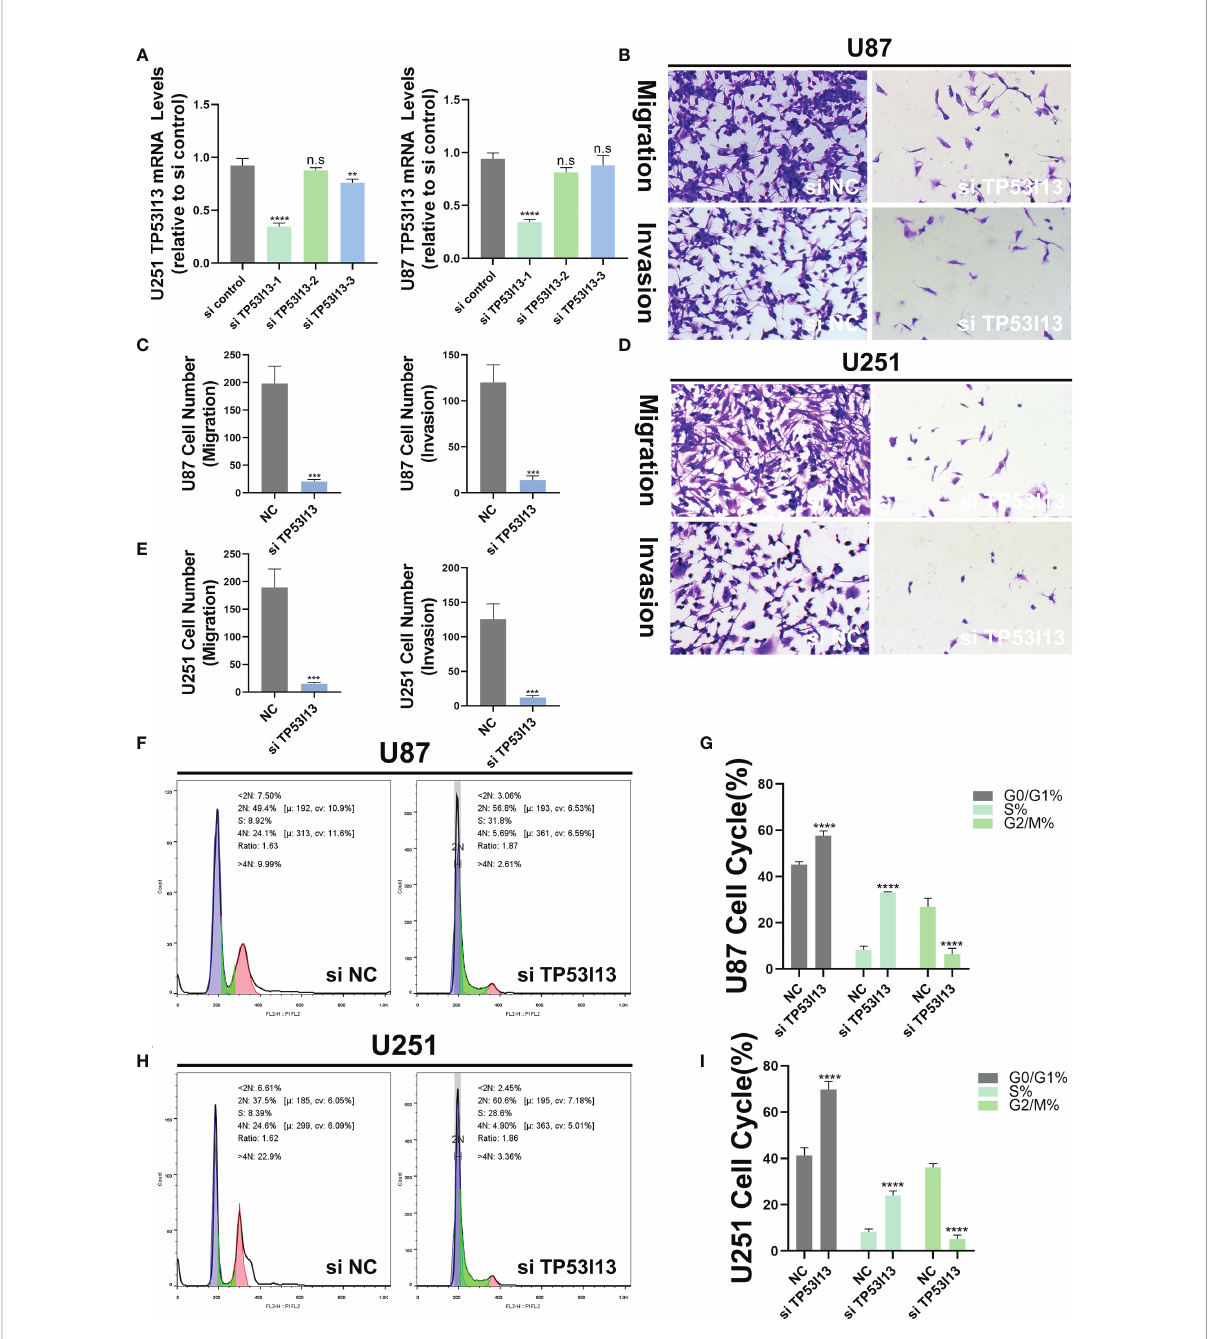
FIGURE 11 TP53I13 promotes glioma cell migration and invasion in vitro . (A) Validation of siRNA interference ef fi ciency in knockdown of TP53I13 expression in U87 and U251 cells by RT-PCR (B-E) Transwell migration and invasion assay in the NC and TP53I13 knockdown cells, and quantitative analysis of cell numbers. (F-I) Flow cytometry was performed on the NC and TP53I13 knockdown cells to detect the cell cycle and to quantify the percentage of cells at different phases. **p ≤ 0.01, *** p ≤ 0.001 and ***p ≤ 0.0001. ns, no signi fi